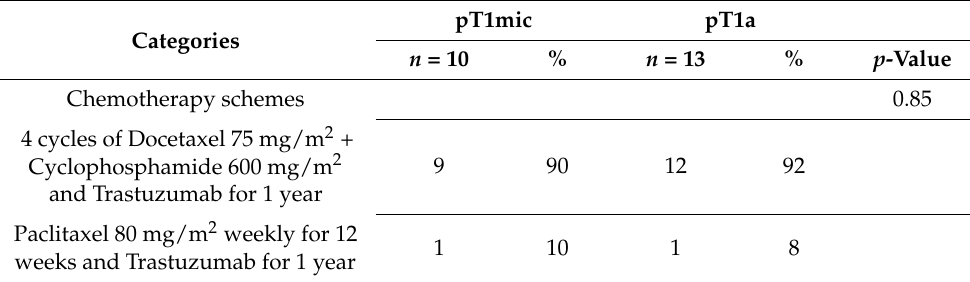
Table 3. Chemotherapy schemes associated with trastuzumab